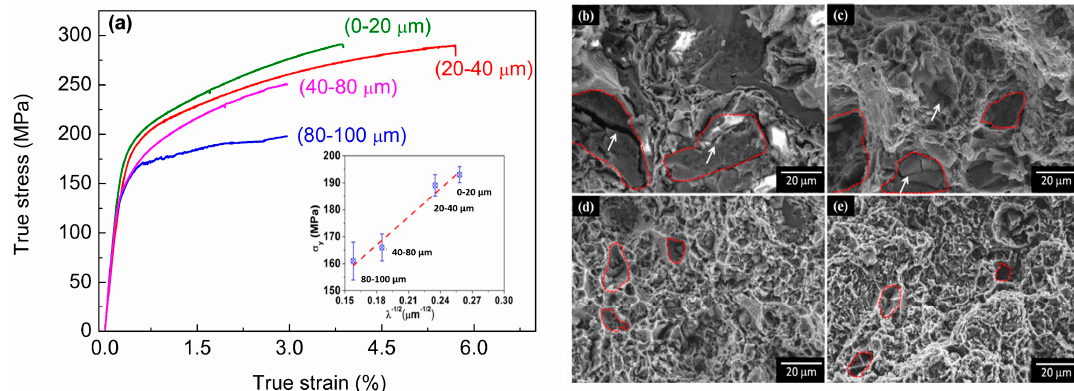
Figure 3. ( a ) Room temperature tensile true stress-true strain curves with inset showing the dependence of yield strength ( σ y ) on λ − 1/2 and SEM micrographs of the fracture surface; ( b ) 80–100 µ m; ( c ) 40–80 µ m; ( d ) 20–40 µ m and ( e ) 0–20 µ m for the hot pressed and hot extruded composites with 10 vol.% of Mg-7.4%Alreinforcement.